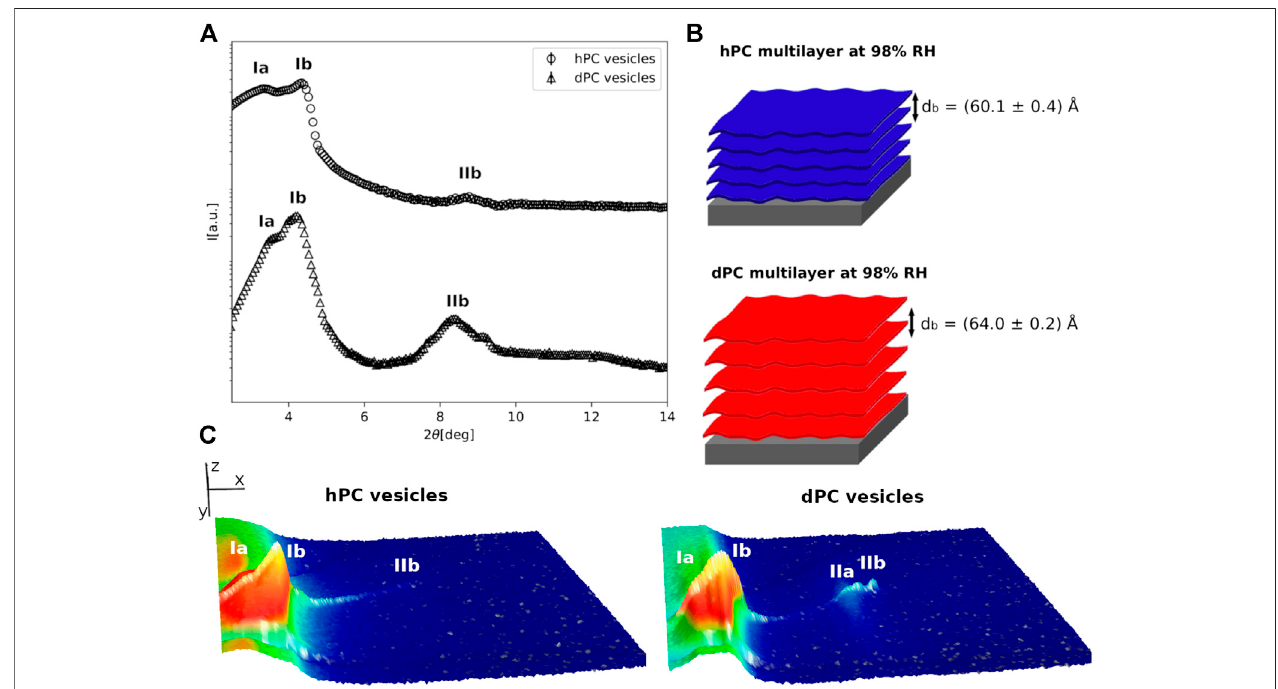
FIGURE 2 | (A) Neutron diffraction data collected for hPC and dPC multilayers at 98%RH prepared by deposition of an aqueous vesicle suspension. (B) Cartoon representationofthetwomultilayerswiththeircharacteristic d -spacing. (C) 3Drepresentationofthedetectorimagescorrespondingtothediffractionpro fi lesreportedin (A) .In (C) thesampleangle( ω )andtheangleatthedetector(2 θ )arereportedonthe x and y directionrespectively,whiletheintensityofthepeakisreportedonzdirection. In (A , C) , the different diffraction peaks are identi fi ed with Roman numbers, while the letters a and b are used to distinguish the different lipid